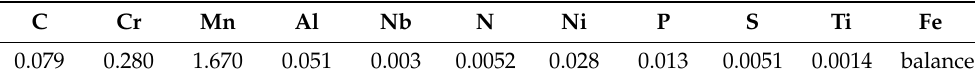
Table 1. Chemical composition in wt%.